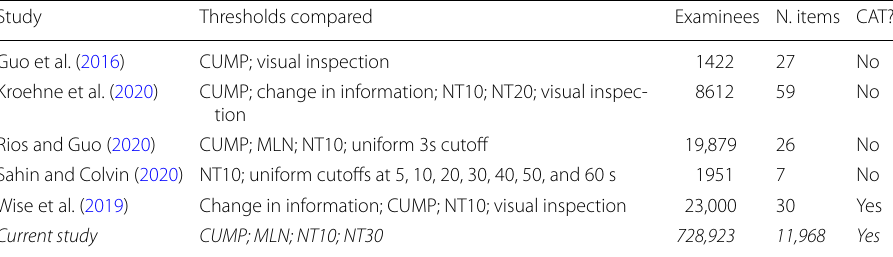
Table 1 Details on studies focused on comparing threshold-setting methods Study Thresholds compared Examinees N. items